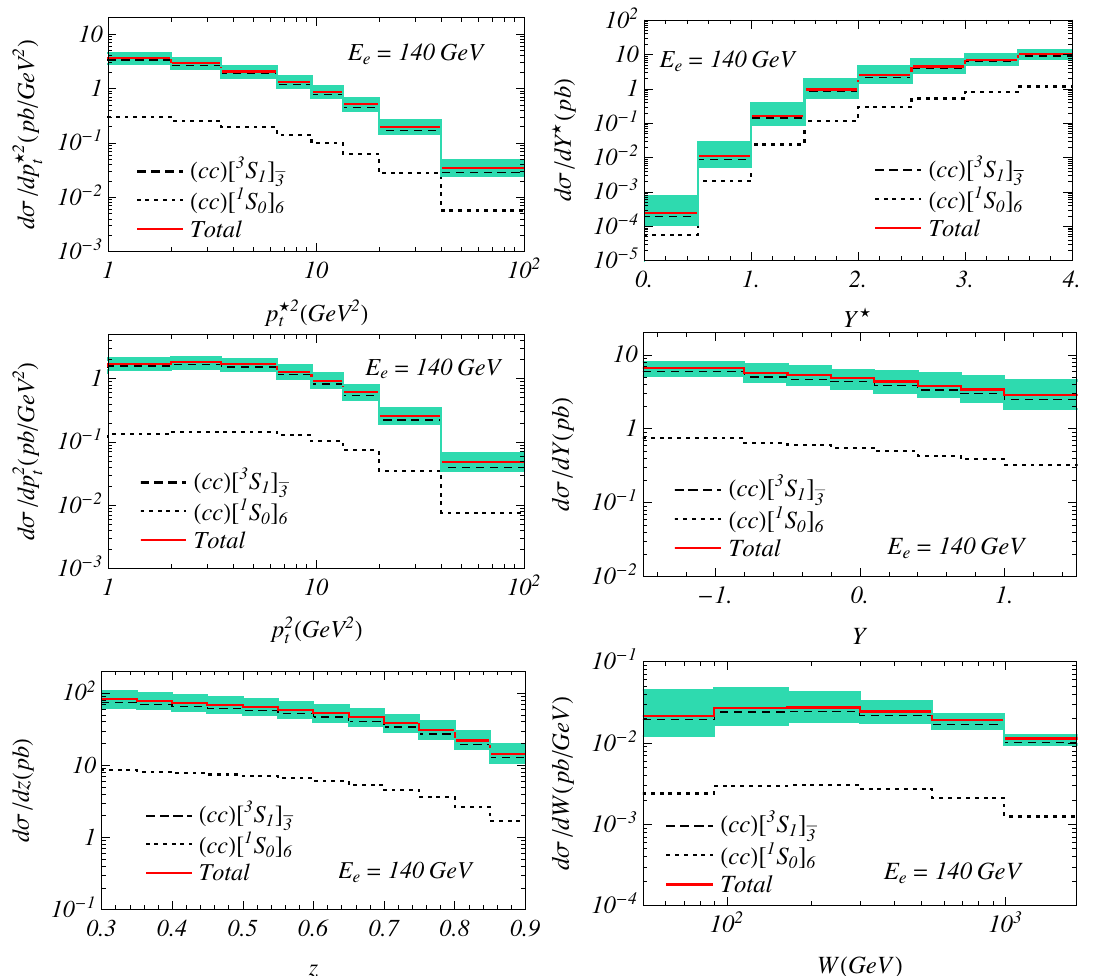
Figure 5 . The distributions of p 2 kinematic cuts of equation (3.1), corresponding to E e = 140 GeV. \ Total " denotes the sum of the contributions via ( cc )[ 3 S 1 ] (cid:22) 0 : 5 (cid:22) 0 to 2 (cid:22) 0